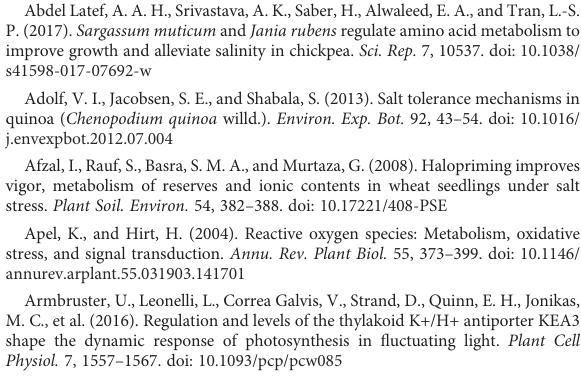
SUPPLEMENTARY FIGURE 1 Effect of different seed priming treatments on germination percentage in BO78 ecotype of quinoa. Seeds were primed with various treatments and then germinated at 300 mM of NaCl (Details in Materials and Methods). Error bars show mean ± SE (n=50). SUPPLEMENTARY TABLE 1 Effect of seed HP on metabolites and biomass under Control or Salinity conditions in two genotypes of C. quinoa . Different parameters were determined in four different individuals ( n = 4). Fully expanded third leaves (from the top part of the plant) were used for measurements. Statistical differences were established (P < 0.05) using three-way ANOVA. The last rows of the table show the signi fi cance levels (P) of the factors (E, S and P) and interactions. Signi fi cant P-values are in bold and red. The underline shows the signi fi cant independent effect that are not included in a signi fi cant interaction, and the more complex interaction that includes the effect of independent factors or more simple interactions (The posterior interpretation is only based on the complex interactions that nests the simple effect, and independent effect that are not included in an interaction). DATASET 1 The fi le shows the metabolome data obtained from the West Coast Metabolomics Center (UC Davis, Davis, CA, USA) using leaves of juvenile plants of two ecotypes of Quinoa subjected to seed priming (UP or